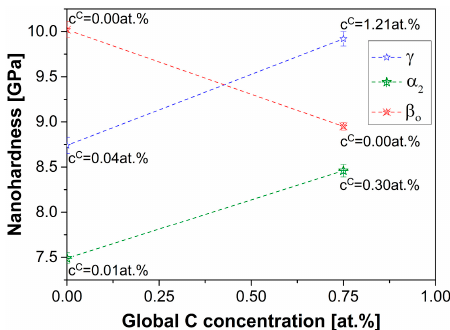
Figure 7. Hardness as measured by nanoindentation of the individual phases of a TNM alloy and a C-containing derivative, TNM0.75C. The error bars indicated correspond to the standard errors of the mean. In the C-free state the β o phase is the hardest phase followed by α 2 and γ . By alloying with C, the latter two phases harden via solid solution hardening, whereas the β o phase softens due to the absence of ω o particles. The C concentration of each individual phase of both alloys as measured by APT is labeled next to the respective hardness values. Dashed lines are indicated only to guide the eye.